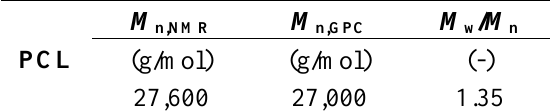
Table 1. Characteristic data of poly( ε -caprolactone)